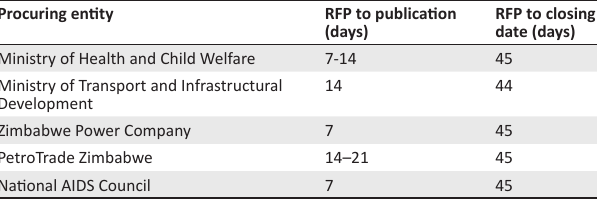
TABLE 7: Period of approval of advert and request for proposal to closing date. Procuring entity